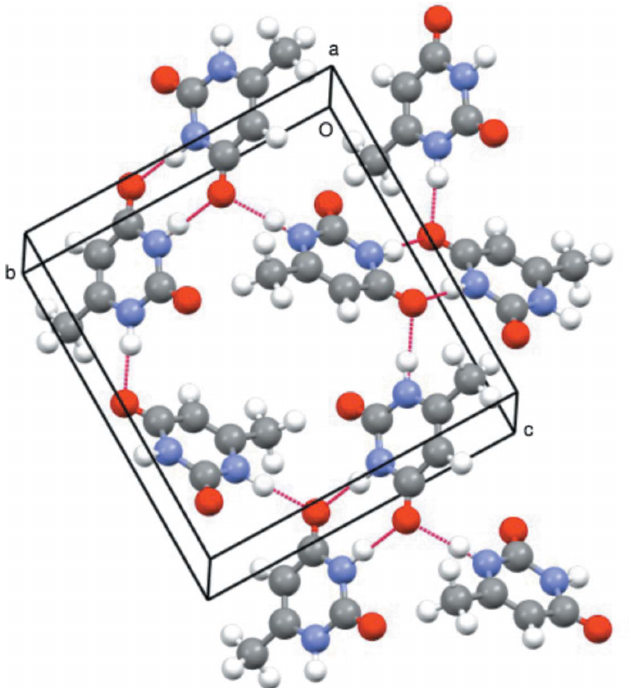
Figure 3 Crystal packing diagram for 6Mura in form (I), viewed approximately down a . All atoms are shown as small spheres of arbitrary radii. Hydrogen bonding is indicated by red dashed lines.